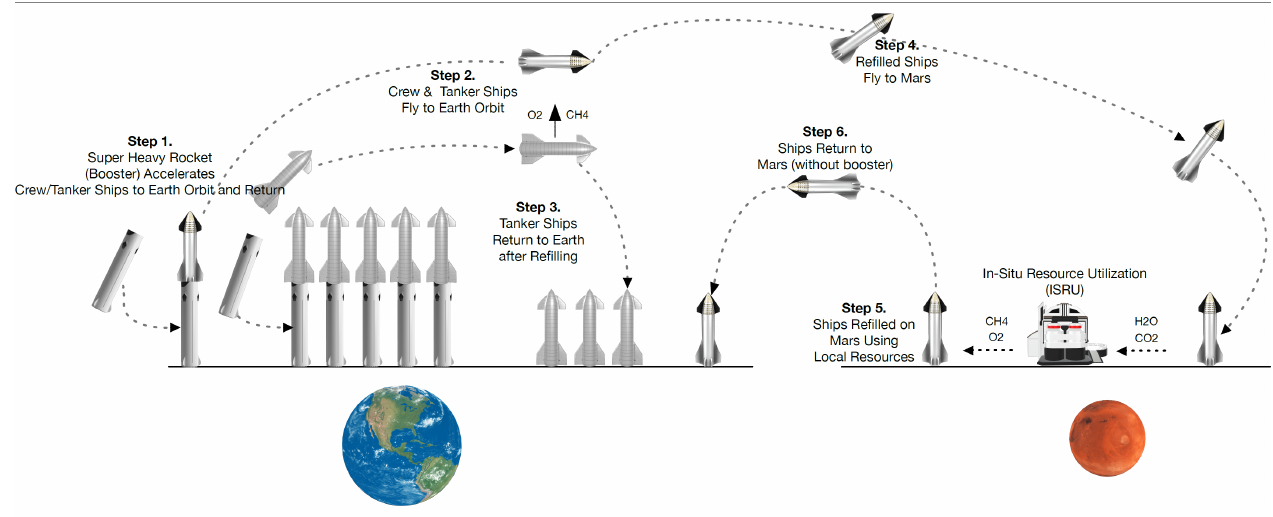
Figure 7. Illustration of Mars transit system architecture and flowchart, based on concept in